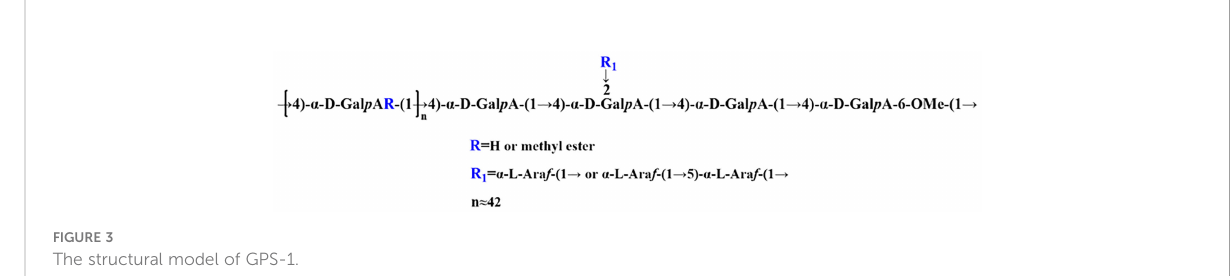
FIGURE 3 The structural model of GPS-1.